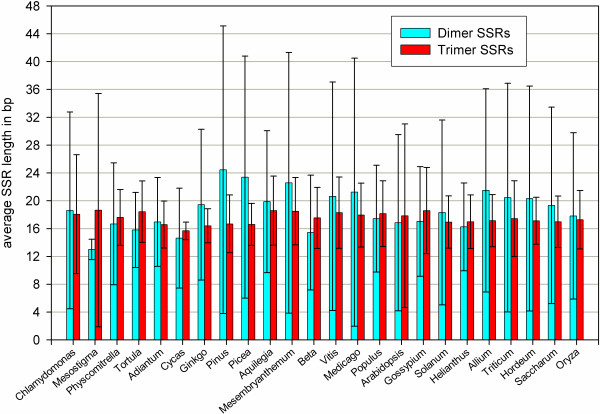
Average length of dimer as well as trimer microsatellites among the gene indices of 24 plants. The average microsatellite length of dimer as well as trimer SSRs in basepairs (+/- standard deviation) as detected in the gene indices of 24 phylogenetically well distributed plant species (see also Additional file 2).